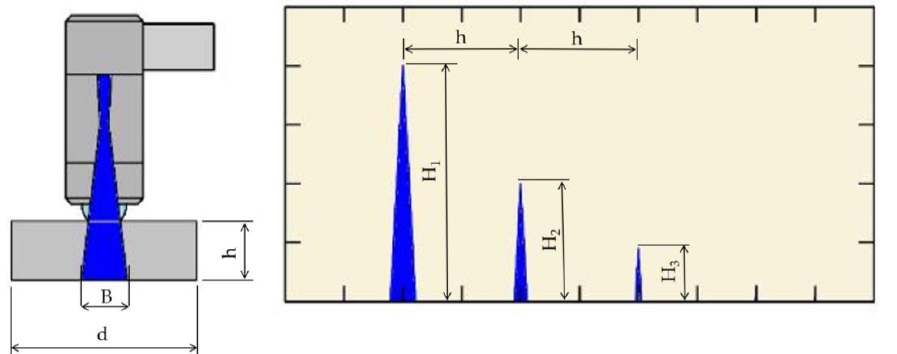
Figure 1. Ultrasonic testing — scheme; h = 10, 25 and 40 mm, d = 25 mm, B — beam diameter in mm, H 1 , H 2 , H 3 — amplitude of pulses from the bottom of the specimen.